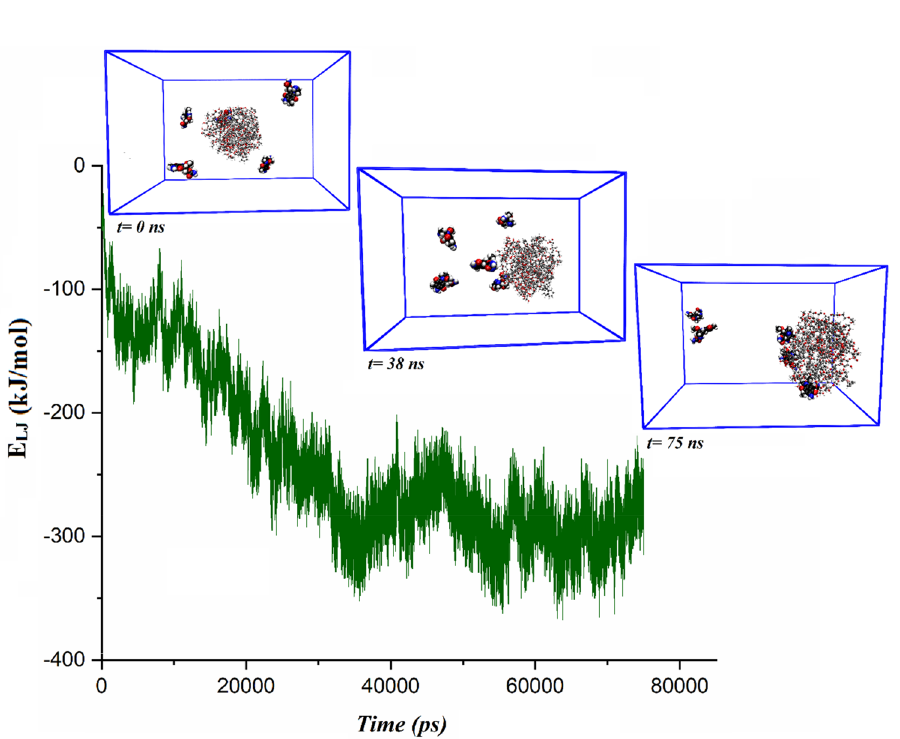
Figure 8. The L–J energy variations in MIC-loading